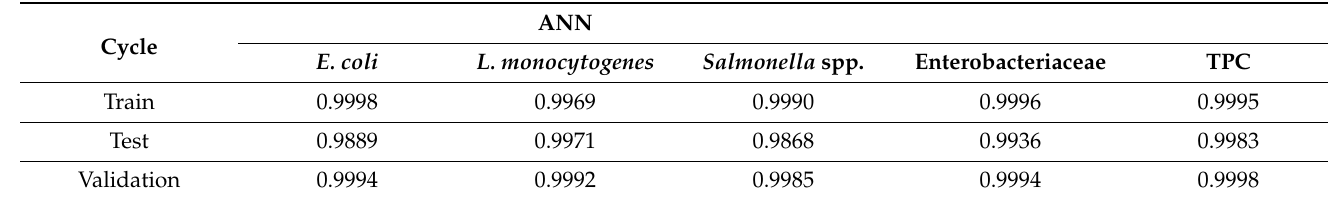
Table 5. Coefficients of determination between experimentally measured and ANN outputs, during training, testing and validation steps.